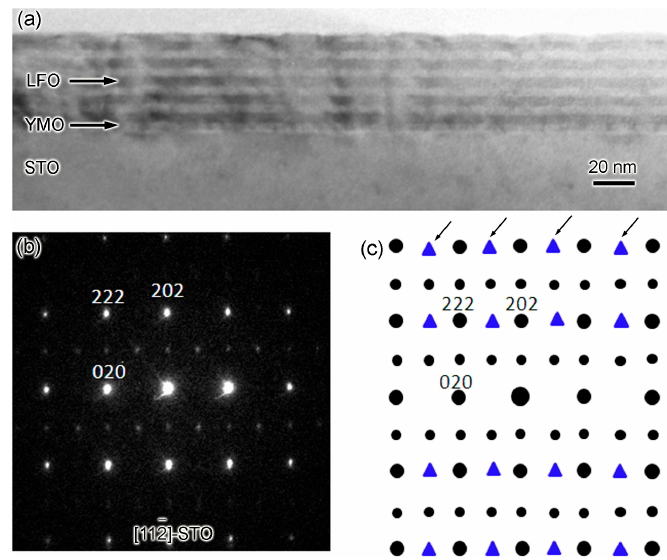
Figure 6. ( a ) The low-magnification TEM image of sample-III grown on (111)-STO substrate; ( b ) is the SAED pattern of sample-III with electron beam aligned along [11 2(cid:3364) ]-STO direction; ( c ) is the schematic of SAED pattern of Figure 6b. Black circles are the reflections observed in the experiment. Blue triangles (highlighted by black arrows) are the extra reflections if there are three types of domains.